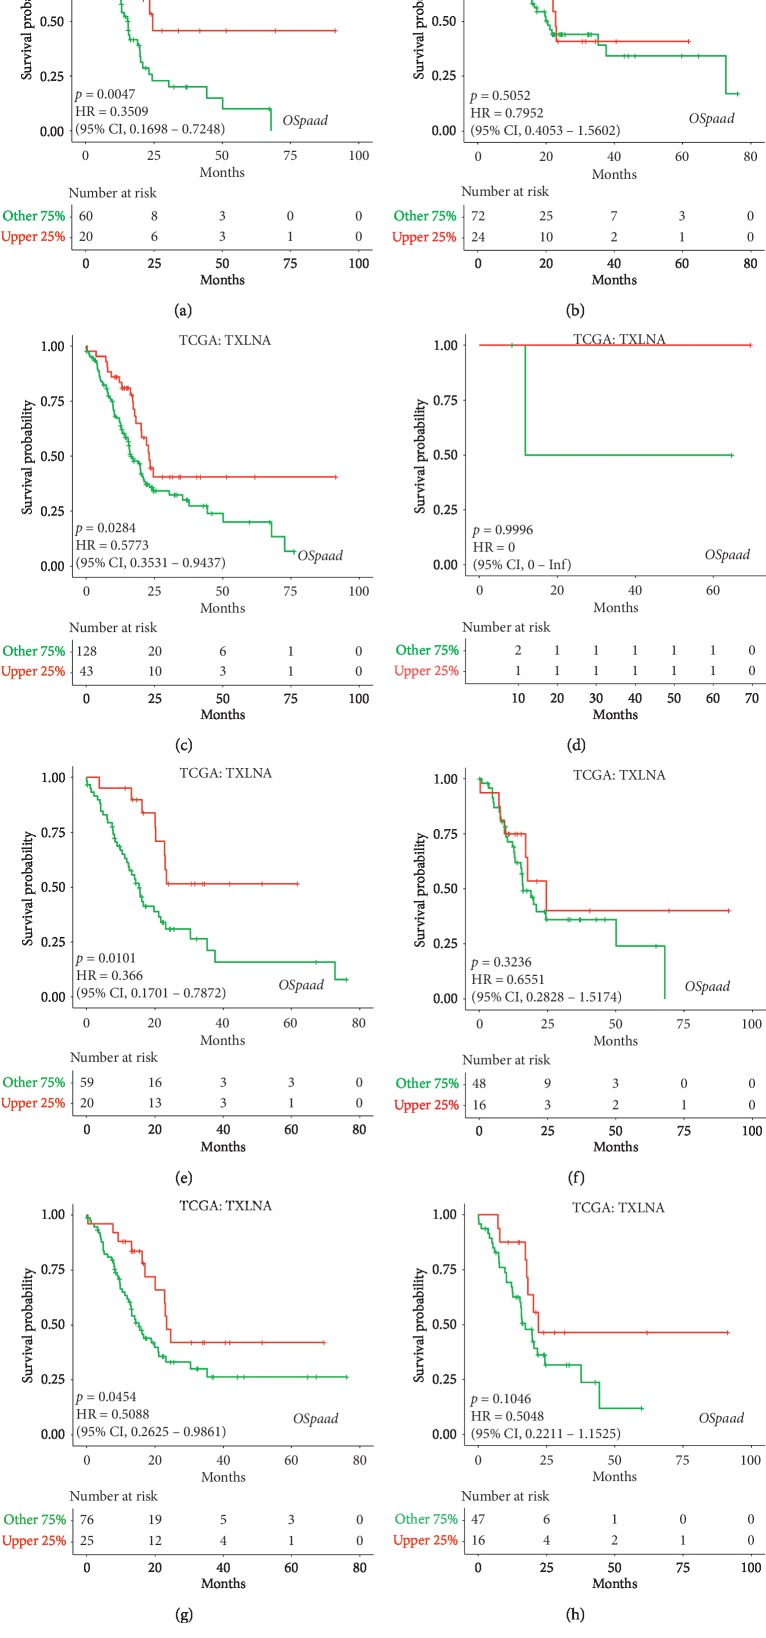
Kaplan-Meier curves of overall survival (OS) in female (a), male (b), lymph nodes (c), no-lymph nodes (d), no-smoking (e), smoking (f), alcohol (g), and no-alcohol (h) from TCGA data in PAAD.